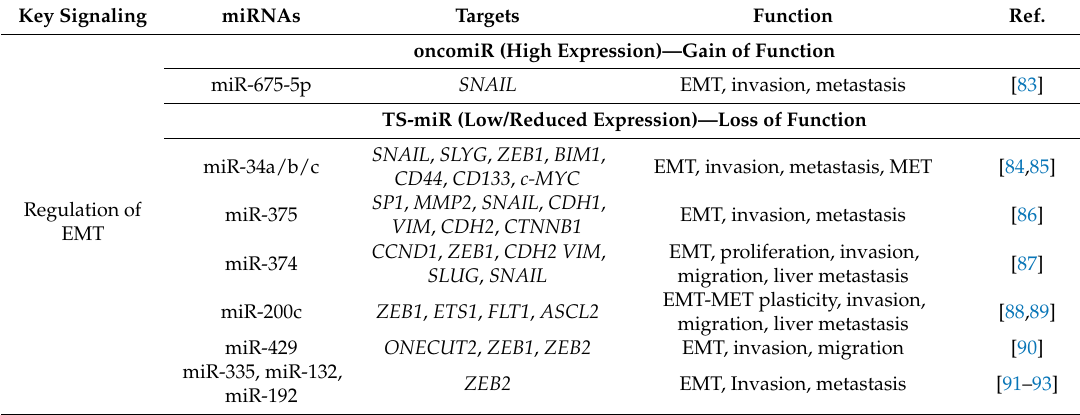
Table 2. MiRNAs and their mRNA targets associated with regulation and induction of epithelial to mesenchymal transition (EMT) and mesenchymal-epithelial transition (MET), supporting CRC invasion and